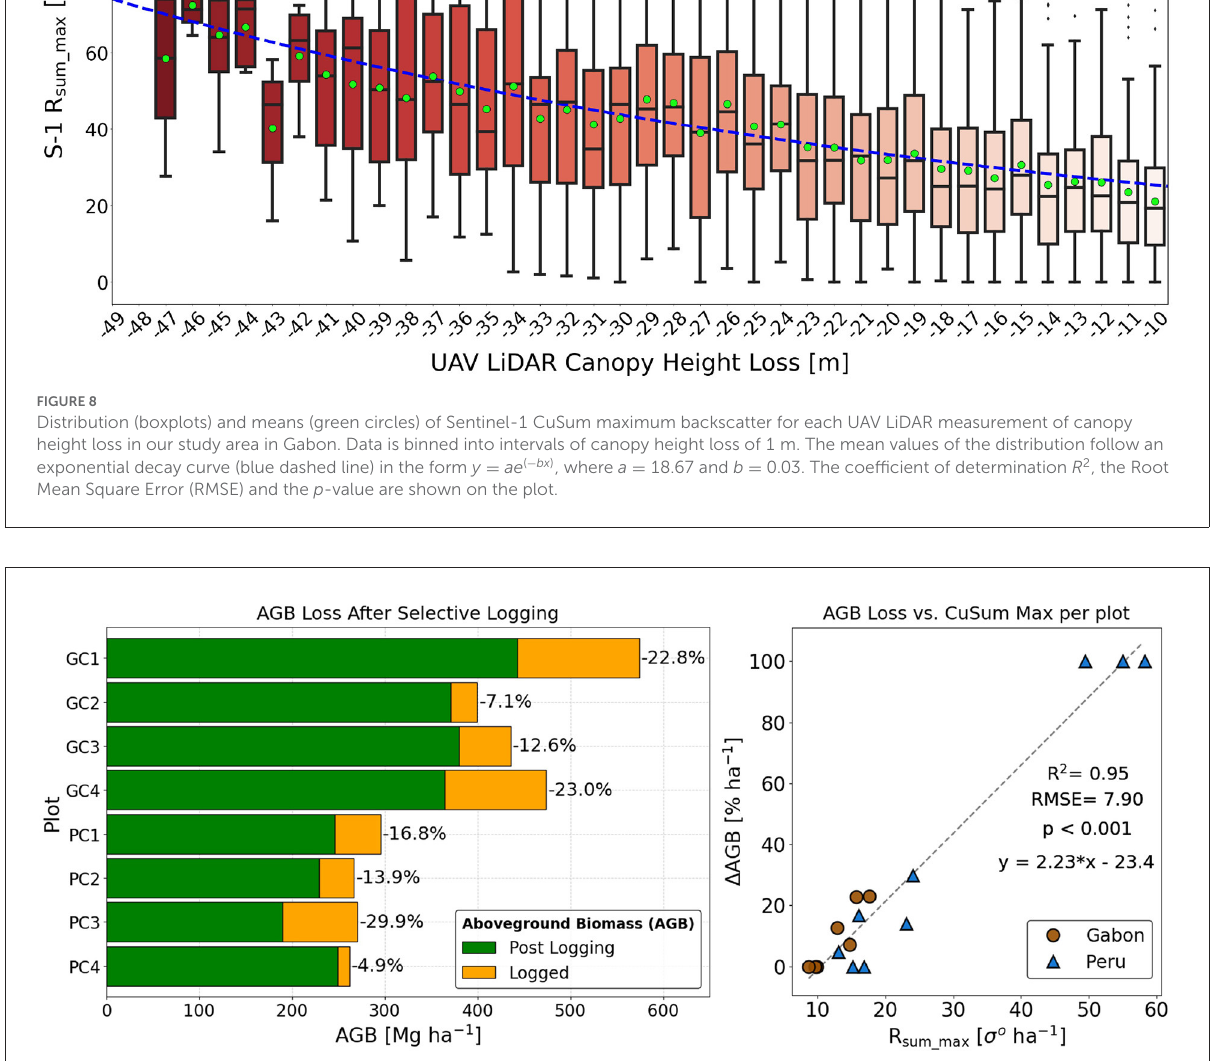
FIGURE9 (left) AGB loss in Mg ha − 1 in the eight 1-ha selectively logged plots in Gabon (G) and Peru (P); (right) AGB loss ( 1 AGB) vs. the maximum of the CuSum curve (R sum_max ) for plots in Gabon (brown circles) and Peru (blue triangles). In addition to the eight field-inventoried plots (right), four undisturbed plots ( 1 AGB = 0%) and three fully deforested plots ( 1 AGB = 100%) were added to the sample